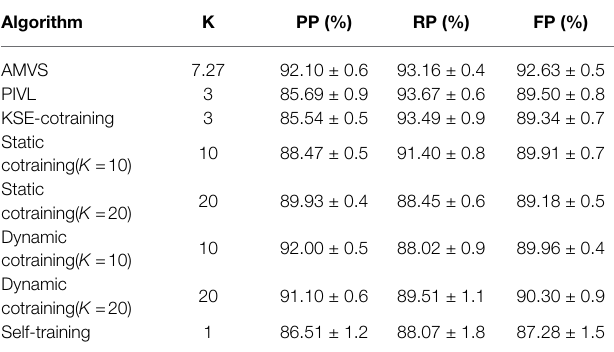
TABLE 4 | Comparison results of recognition algorithms when the label-free rate is taken as 0.5 (base classifier is SVM). Algorithm